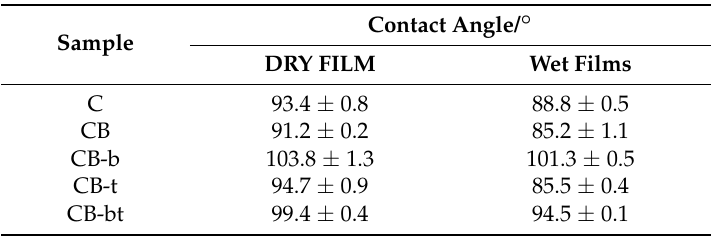
Table 1. The impact of cross-linking treatment on the contact angle of dry and wet films from chitosan (C), 1/32 bacterial cellulose/chitosan (CB), and 1/32 bacterial cellulose/chitosan treated with